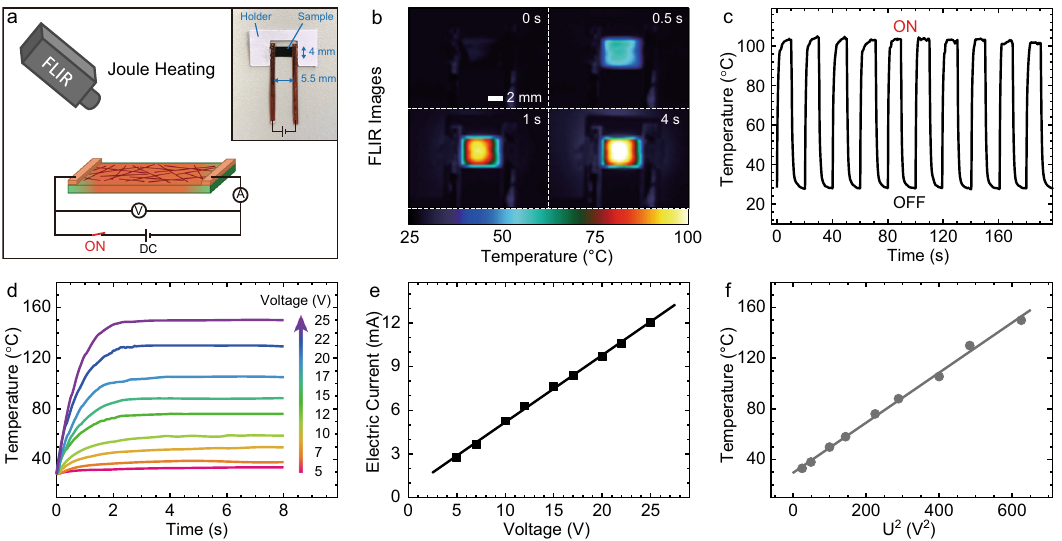
Fig. 2 Joule heating of CNF/EG-UPy 29 /SWNT (50/50/10) nanocomposites by applying DC voltage. a Illustration of the measurement setup for Joule heating using a FLIR camera. The inset shows a photograph of the sample with copper electrodes. b FLIR images of the nanocomposite under applied voltage of 17 V. c Heating/cooling cycles under applied voltage of 17 V. d Time-dependent heating plots for different voltage. e The electric current as a function of voltage in the closed circuit. f The steady-state temperature as a function of square of voltage (see Eq.